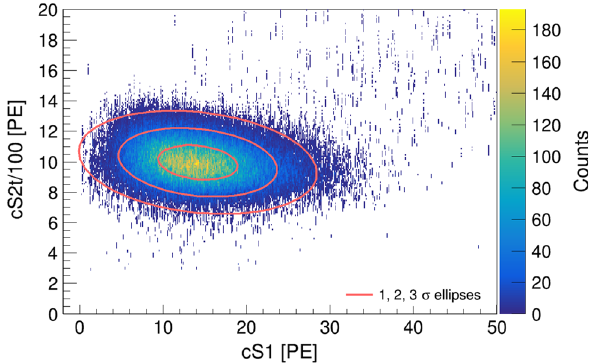
Fig. 10 2 . 82keV line of 37 Ar in S2 top versus total S1 space at 968V/cm. The ellipses show the 1 , 2 , 3 σ regions of the distribu- tion. The SiPM top array collects 23 . 5% of the total detected S2 light (cf. Fig. 9,